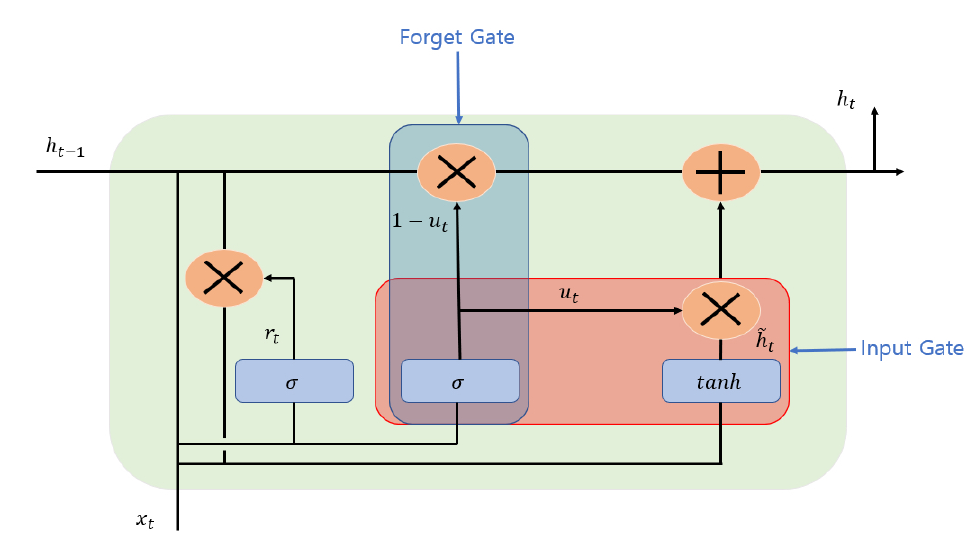
Figure 7. Gated recurrent unit